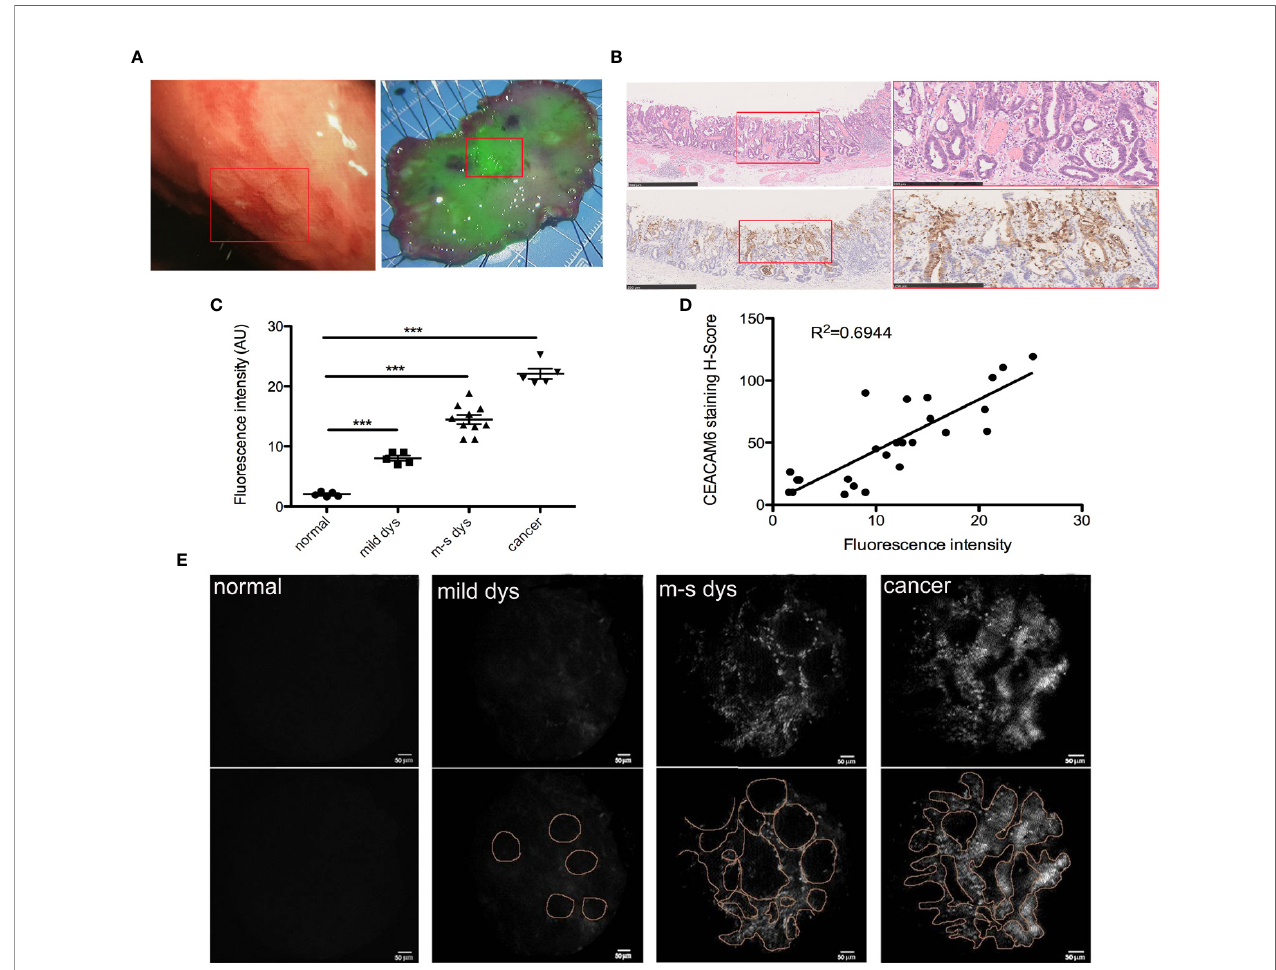
FIGURE 7 | CEAACM6-mAbIRDye800CW probe labeled the gastric mucosa with dysplasia. (A) The white light endoscopy of the lesion in upper gastric body (left panel), the ESD was carried out and the specimen was got, the specimen was fi xed on the board with pin on the edges, and fl ushed with running tap water to remove the mucus on the surface, then the CEAACM6-mAb-IRDye800CW probe was sprayed on the surface of the specimen evenly and incubated, then the detector of the wide fi eld fl uorescent endoscopy was used to check the fl uorescent intensity, the mucosa binding the probe showed the green fl uorescent signals, the intensity of the signals indicated how much the probe be binded. The depressed gastric mucosa at the center of the specimen showed the strongest green signals and was signed in the white box. (B) After fl uorescent probe study, the specimen was fi xed with formalin and the HE staining were investigated (upper panel), the depression was signed with red box (left panel) and was ampli fi ed (right panel), the glands were irregular and the nucleus were large and hyperchromatic. IHC staining of CEACAM6 in the specimen of ESD operation (down panel). The depressed gastric mucosa was showed in the red box (left panel) and was ampli fi ed (right panle), the positive of CEACAM6 expression was showed in the brown. Scale bars in left panel = 500 m m, Scale bars in right panel = 250 m m. (C) The mean fl uorescence intensity in the gastric mucosa with different lesions was quanti fi ed by Image-Pro Plus software (fold change from normal), Data are expressed as the means ± SD, the normal mucosa=5, mucosa with mild dysplasia=5, mucosa with moderate dysplasia=5, mucosa with severe dysplasia =5 and mucosa with cancer=5, m-s dys: moderate or severe dys. ***P < 0.001. (D) The correlation between fl uorescence intensity and CEACAM6 IHC staining index was studied by Pearson correlation coef fi cients. (E) The micro structure of gastric mucosa surface was observed by the fl uorescent micro endoscopy detector. The surface micro structure was showed in upper panel and the pattern diagrams were drawn (low